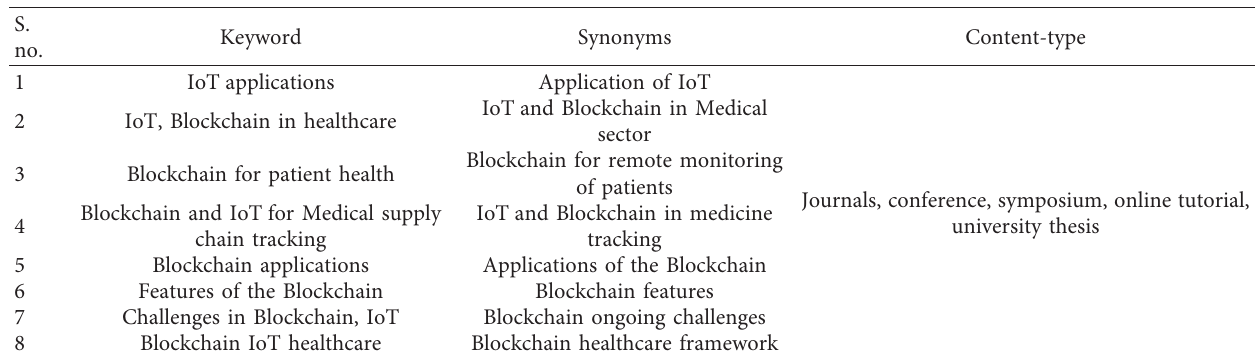
Table 2: Search strings.